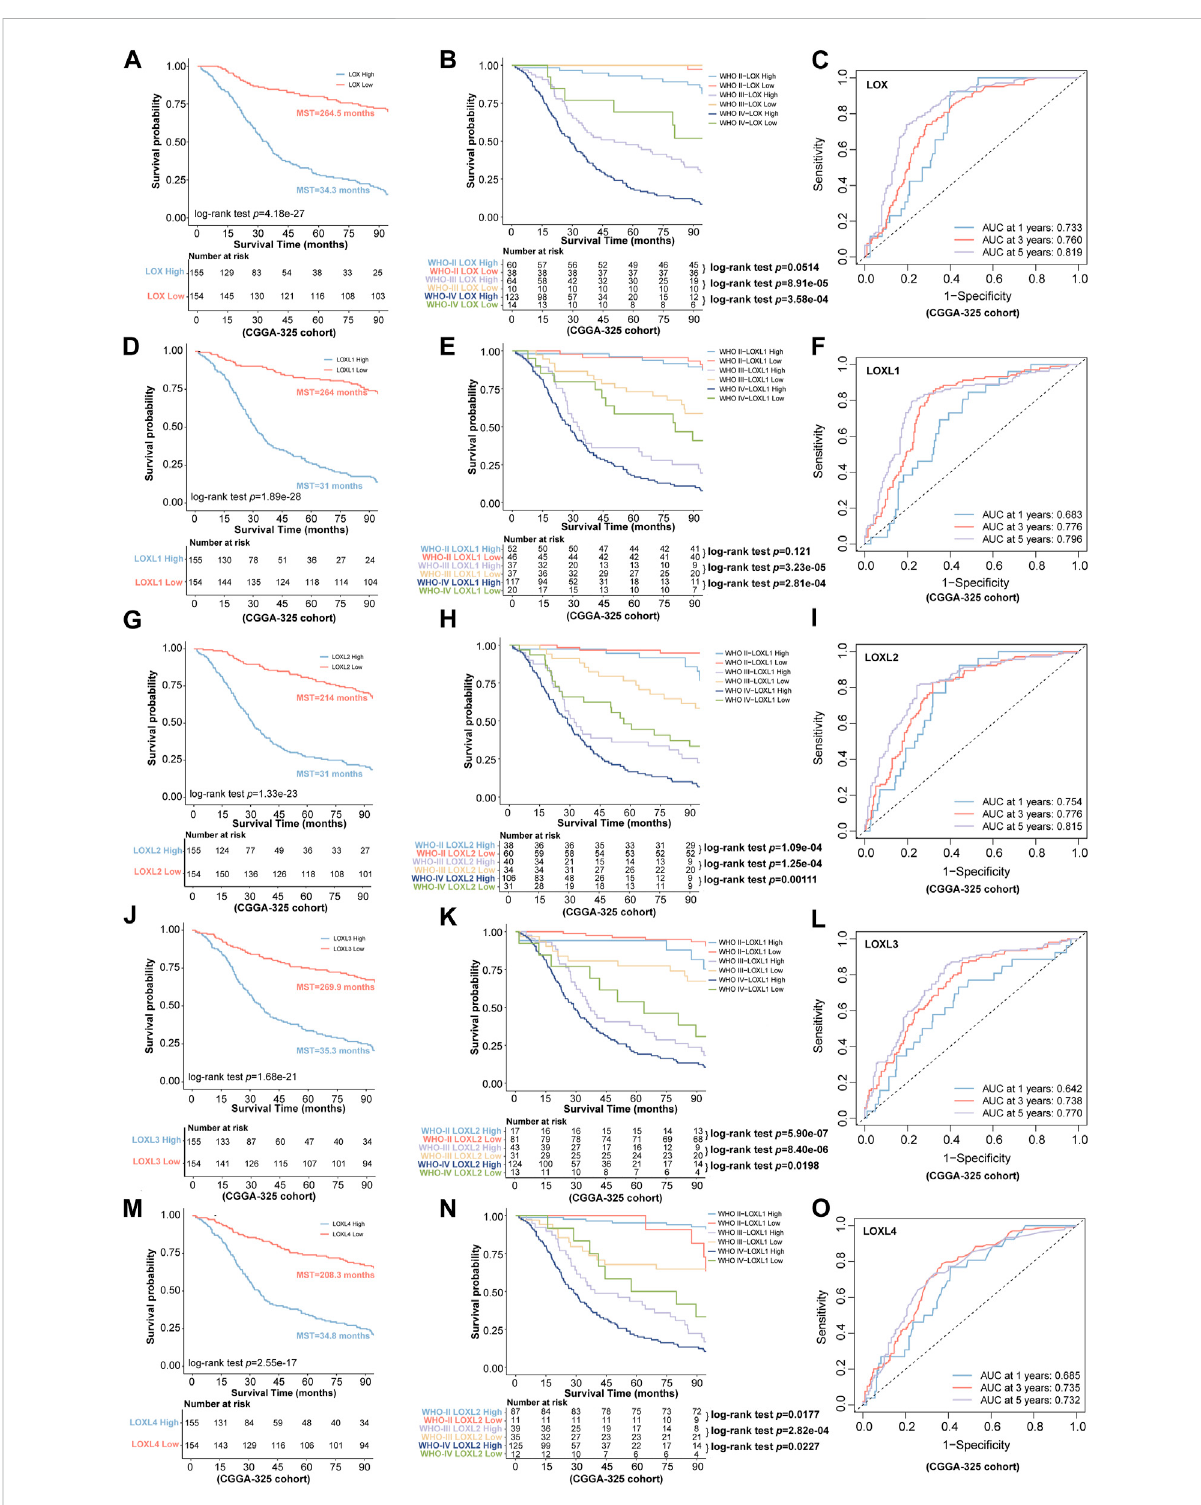
FIGURE 4 Association of LOXs expressions with prognosis in glioma in CGGA-325 cohort. (A,D,G,J,M) the predictive values via differential expressions of LOXs including LOX and LOXL1-4; (B,E,H,K,N) indicate the patients ’ prognosis with differential expressions of LOXs including LOX and LOXL1-4 in different glioma grades; (C,F,I,L,O) the predictive value of distinct LOXs expressions in the aspect of 1 year AUC, 3 years AUC and 5 years AUC via ROC curve